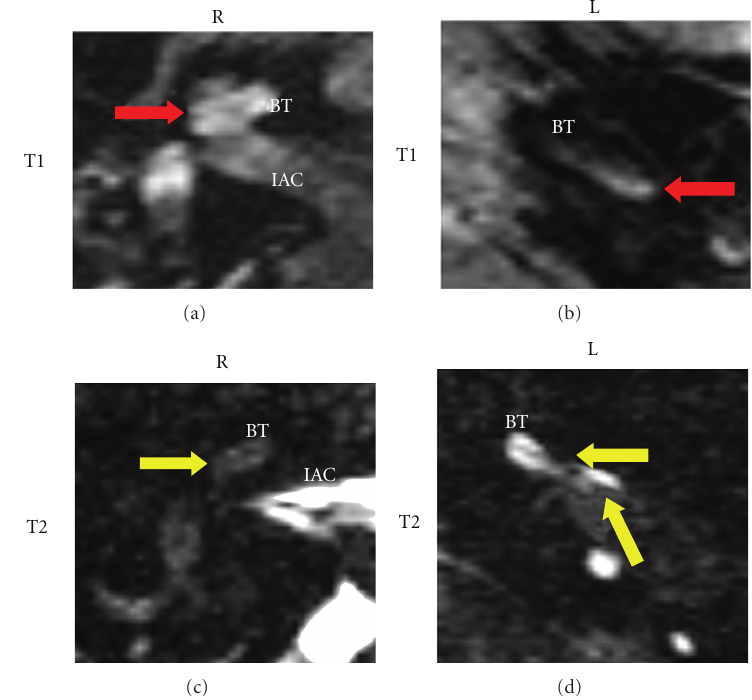
Figure 1: MR images of the right (R) and left (L) inner ears of a patient (case 2) after pneumococcal meningitis. Depicted are the axial T1 weighted MR images with contrast enhancement (T1, top row) and the T2 weighted MR images (T2, bottom row). The patient, a boy aged 7 months, su ff ered from asymmetric hearing loss after pneumococcal meningitis. Auditory brain stem response (ABR) audiometry showed a deaf ear on the right side and a sloping hearing loss (60dB at 3KHz) on the left side. Red arrows show contrast enhancement in the cochlea on the T1 weighted images of both ears ((a) and (b)). The contrast enhancement involves the whole cochlea and vestibulum on the right side, but it is limited to the basal turn (BT) on the left. Yellow arrows show loss of fluid in the cochlea on the T2 weighted images on both sides ((c) and (d)). Whereas on the right side, the loss of fluid involves the complete cochlea and the basal turn is barely visible, the loss of fluid only partially involves the basal turn of the left cochlea. IAC: internal auditory canal.